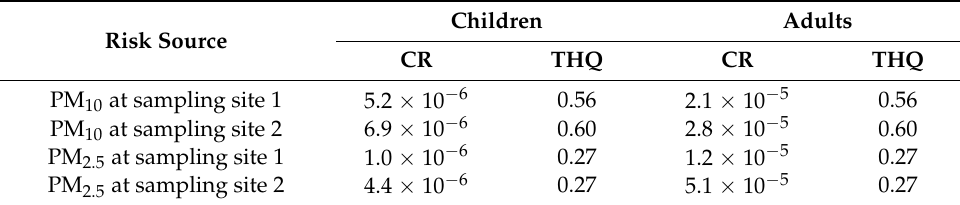
Table 2. The carcinogenic risk and non-carcinogenic risks of human exposure to PM.